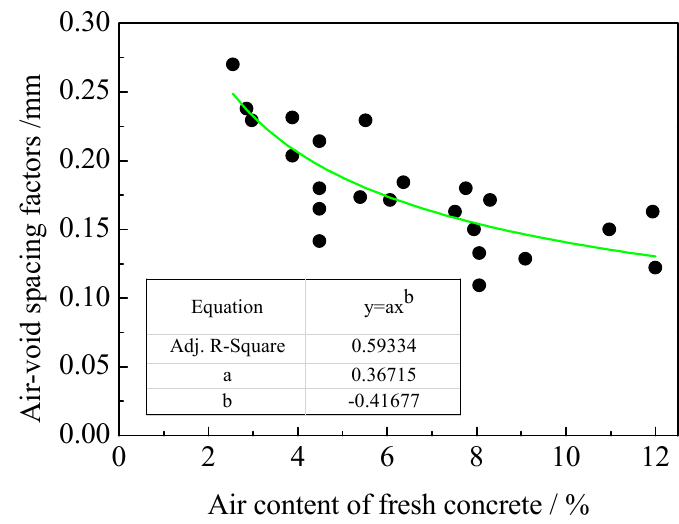
Figure 6. The relationship between air content and the air-void spacing factor of fresh concrete.